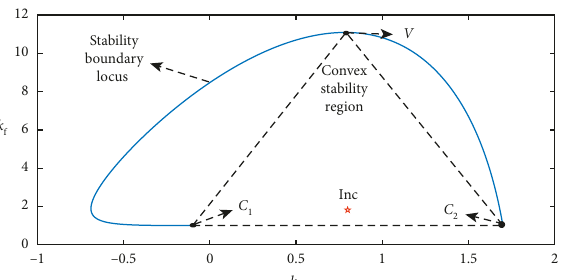
Figure 18: Convex stability region designed by regular point in example E.